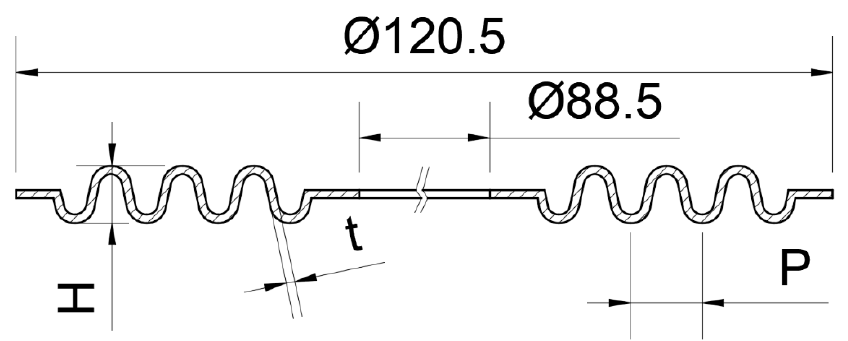
Figure 6. Structural diagram of NiTi alloy corrugated gasket: H, gasket height; t, plate thickness; P, corrugation pitch. corrugation